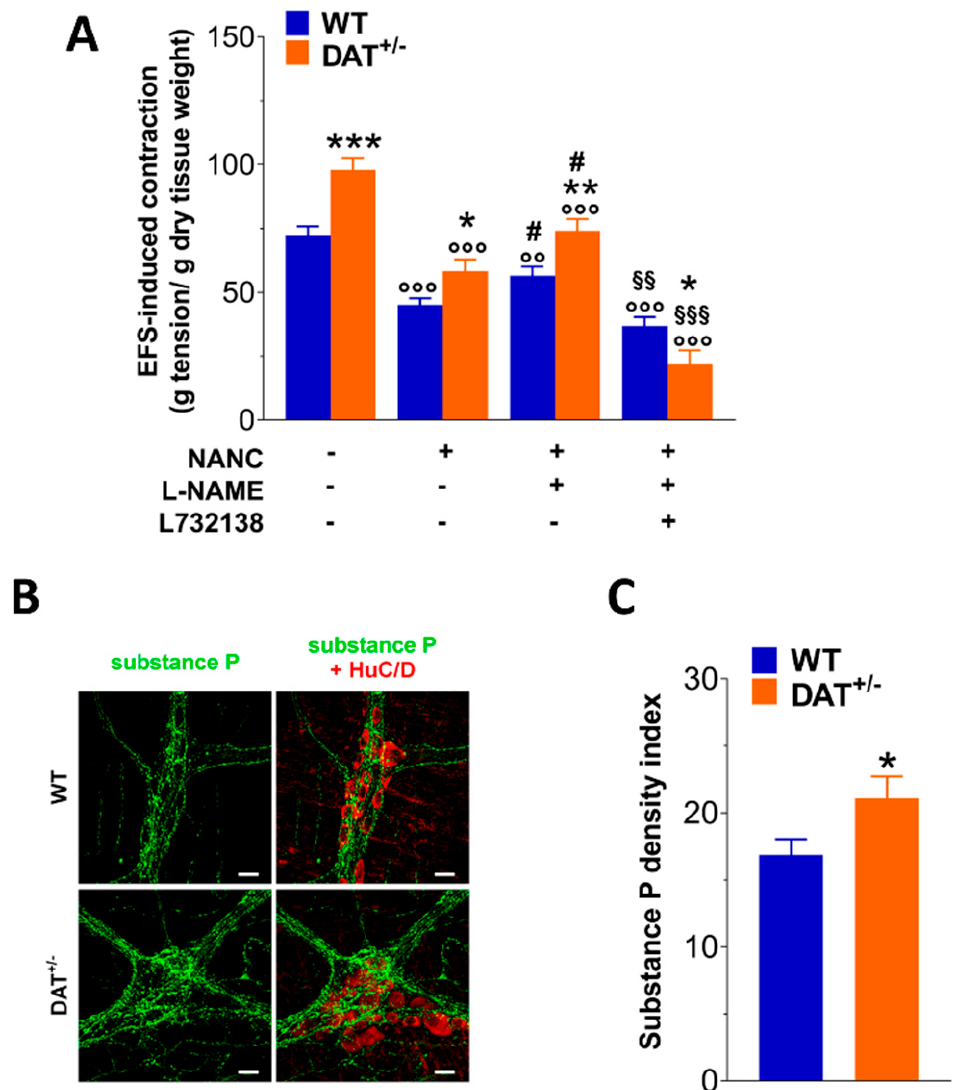
Figure 5. DAT hypofunction influences tachykininergic neurotransmission. ( A ) Tachykininergic nerve-evoked contractions induced by 10 Hz-EFS, in NANC condition with or without L-NAME or L732138 in isolated ileal preparations of WT and DAT +/ − mice. ( B ) Representative confocal microphotographs showing the distribution of substance P (green) and HuC/D (red, pan-neuronal marker) and ( C ) substance P density index in LMMP preparations of WT and DAT +/ − mice. Scale bars = 22 μ m. Data are reported as mean ± SEM. * p < 0.05, ** p < 0.01, *** p < 0.001 vs. WT mice; °° p < 0.01, °°° p < 0.001 vs. respective control in absence of antagonists; # p < 0.05 vs. respective control in NANC condition; §§ p < 0.01, §§§ p < 0.001 vs. respective control with L-NAME. n = 5 mice/group.